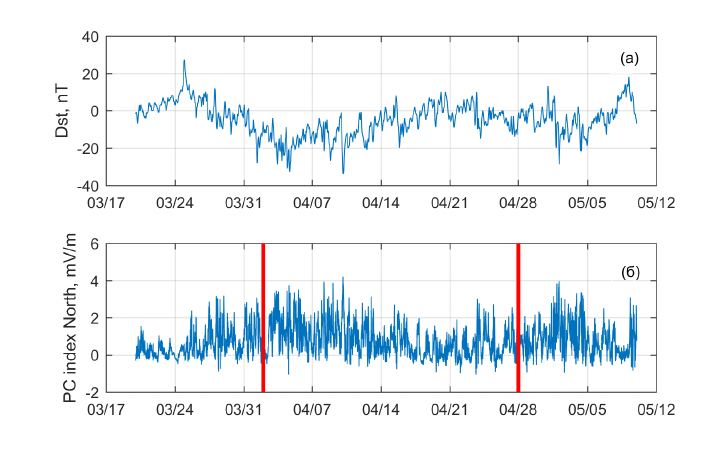
Figure 7. Global magnetic activity during TRANSARCTIC-2019: (a) Dst index (http: // wdc.kugi.kyoto-u.ac.jp / dstae / index.html); (b) Polar caps index (PC North, ISGI, http: // isgi.unistra.fr). Vertical lines mark the beginning and end of measurements using